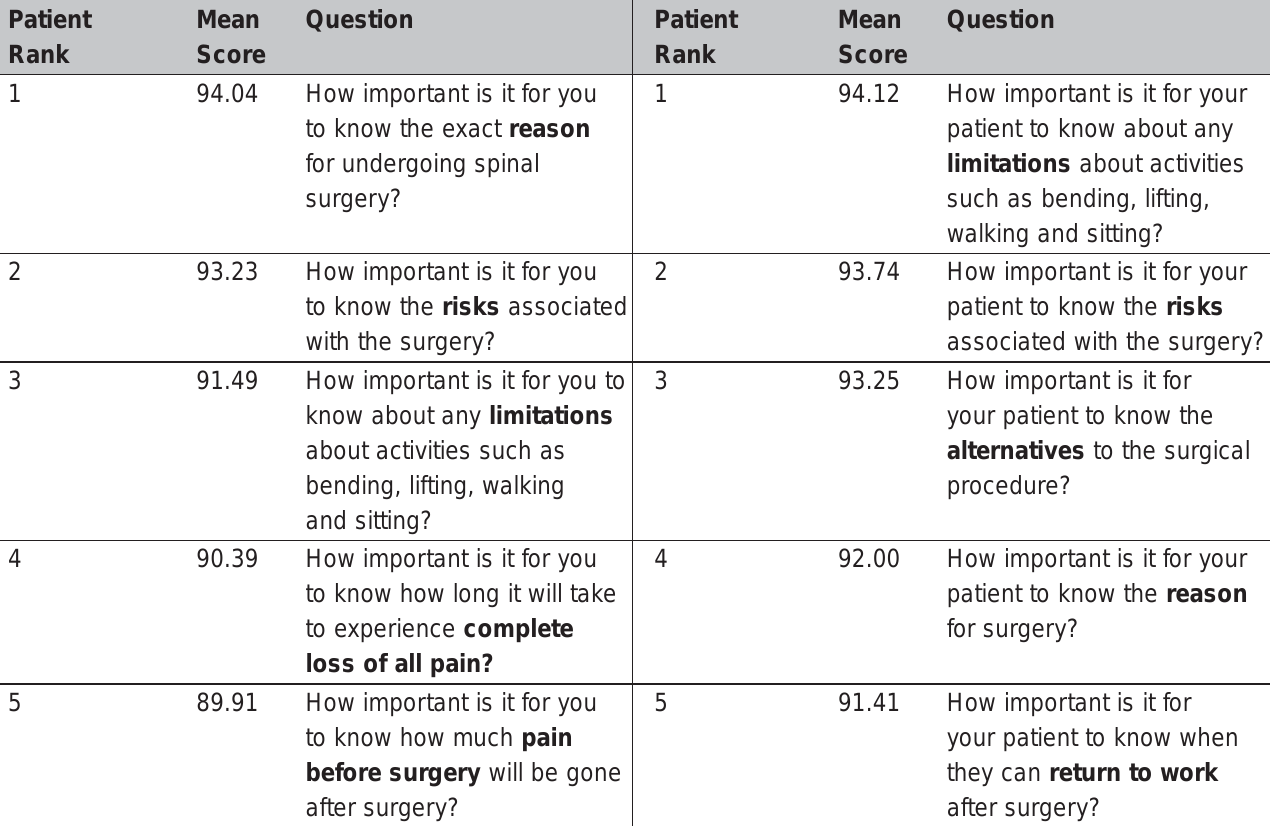
Table 3: Ranking by patients and physiotherapists of the 5 most important issues in regards to preoperative education for lumbar spine